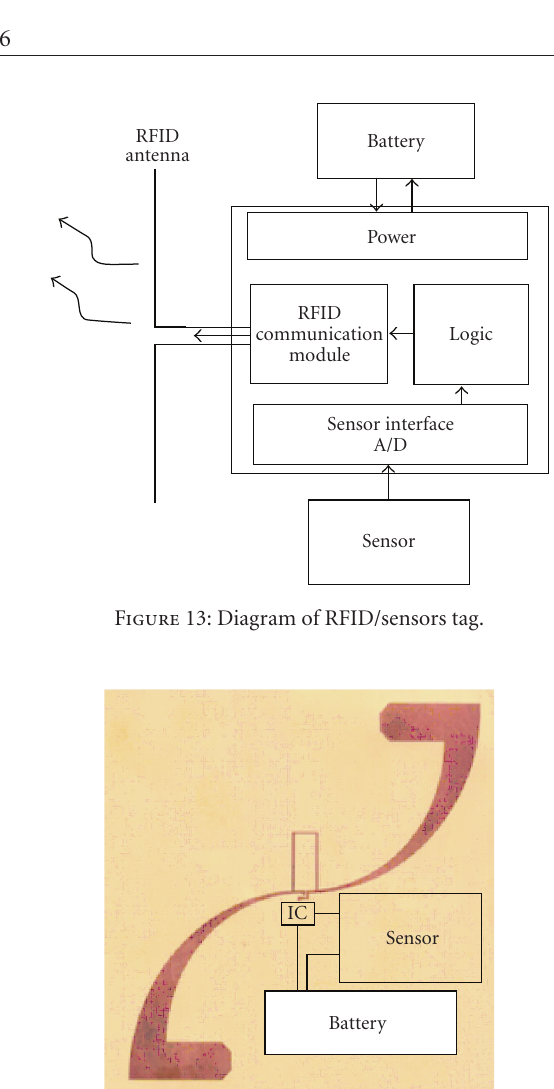
Figure 14: Suggested outline of integrated S-shaped antenna with IC, sensor, and embedded